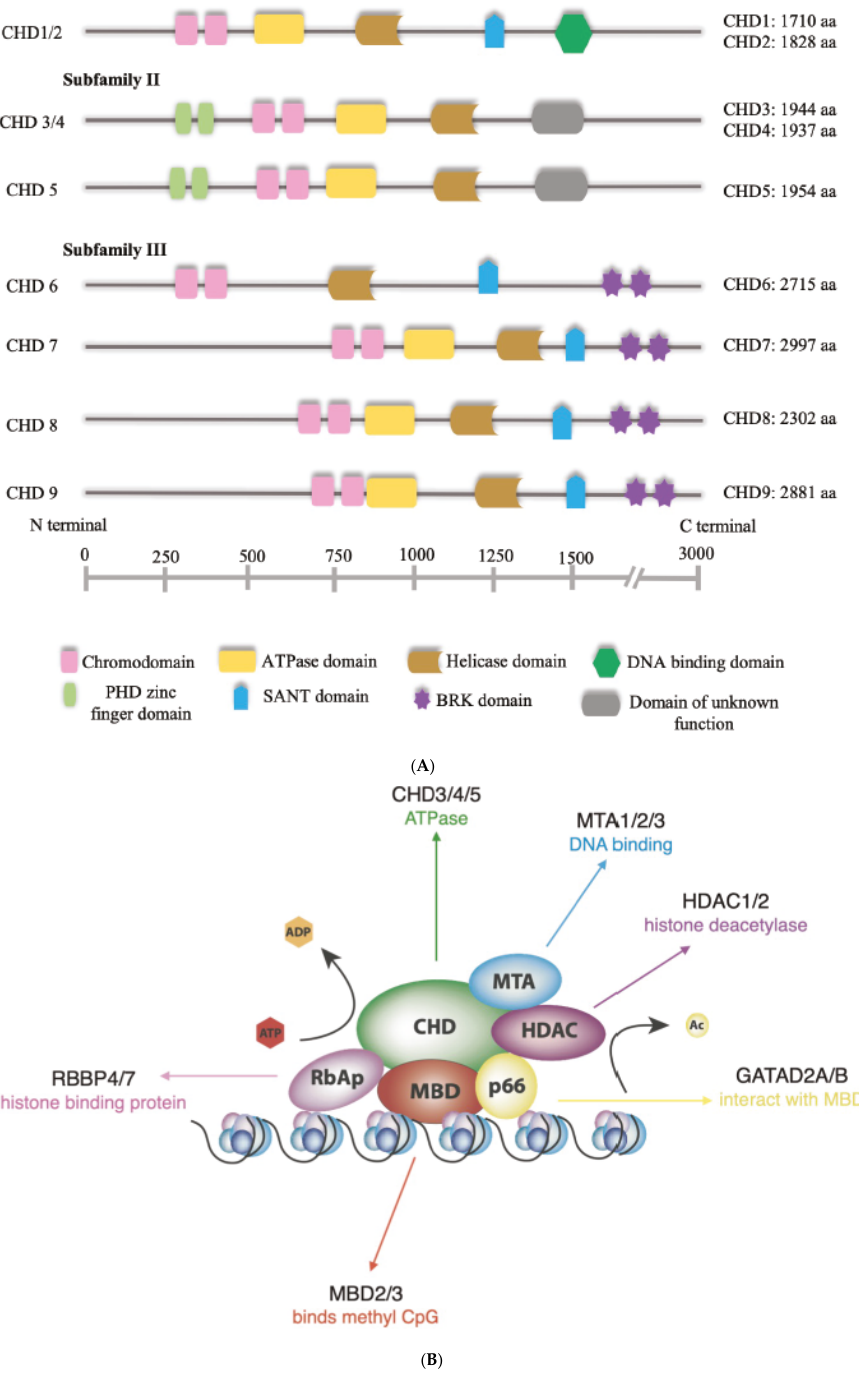
Figure 1. ( A ) Schematic representation of human CHD proteins subfamilies, showing the approximate size and all known or predicted domains. ( B ) The NuRD complex. The primary components of the NuRD complex include the ATP-dependent remodelling enzymes CHD3/4/5, the histone deacetylases HDAC1/2, the sca ff old proteins MTA1/2/3, the histone chaperones RBBP4/7, the CpG-binding proteins MBD2/3, p66 α and/or p66 β . NuRD complexes uniquely couple ATP-dependent chromatin remodelling with his- tone deacetylase activity, by recruiting the histone deacetylases (HDAC) 1 or HDAC2 (Fig- ure 1B) [18]. HDAC 1 and 2 bind extensively to the mammalian genome and are found in association with several transcription factors and chromatin-binding complexes, such as Sin3, CoREST and the Polycomb repressive complex [23]. MBD2 and MBD3 are DNA- binding proteins that possess di ff erent a ffi nities for methylated DNA and are mutually exclusive within the NuRD complex [24]. Additional structural proteins include MTA1, MTA2 and MTA3 that act as the sca ff old around which the NuRD complexes are assem- bled [25]. Given that NuRDs depleted of CHD are stable, bind chromatin and show deacetylase activity [20], it is possible that NuRD composition may have an impact on their function that goes beyond determining the chromatin-binding sites and may extend to whether they induce nucleosome sliding or only histone epigenetic modi fi cations. Thus, one of the most important challenges of future research will be to determine the exact subunit composition of NuRD complexes on speci fi c genomic sites, considering not only the paralogs included but also the potential absence of ATPases altogether, as it will have a profound impact on how NuRD regulates gene expression.